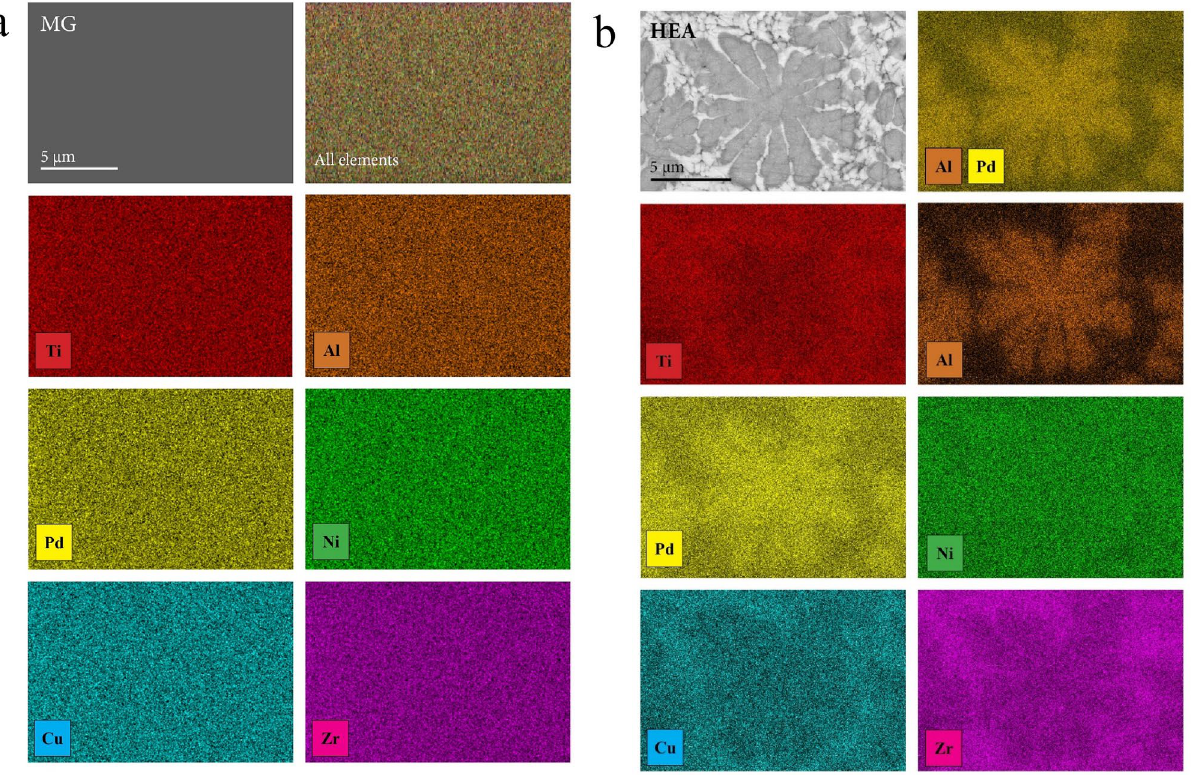
Figure 2. SEM EDS elemental maps of the Al 0.5 TiZrPdCuNi alloy in ( a ) the MG state and ( b ) the HEA state. The upper left panel shows the SEM BSE